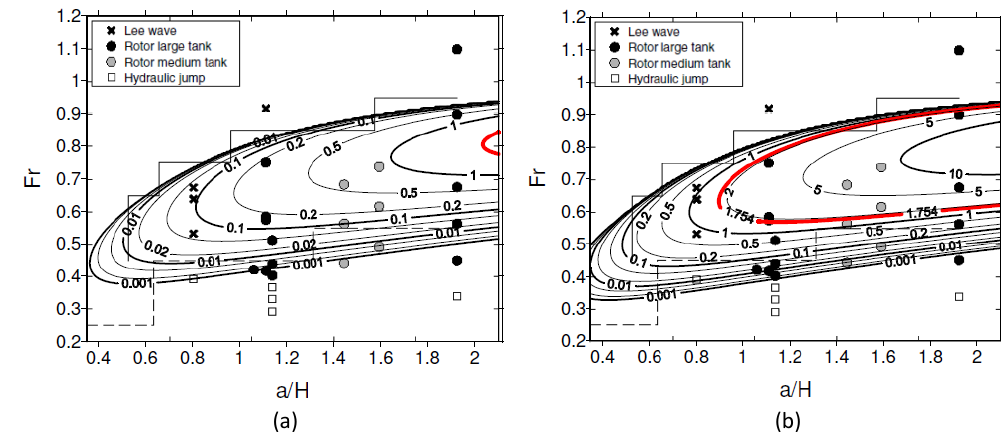
Figure 3. ( a ) and ( b ) should replace Figure 7a,b in